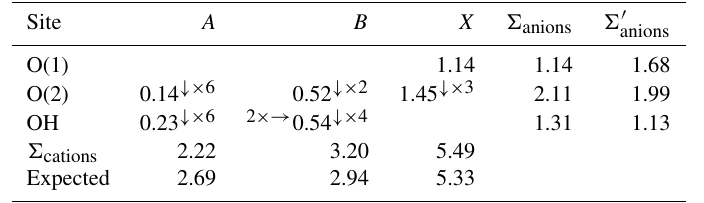
Table 6. Weighted bond valences (in valence units) in graulichite-(La). Site